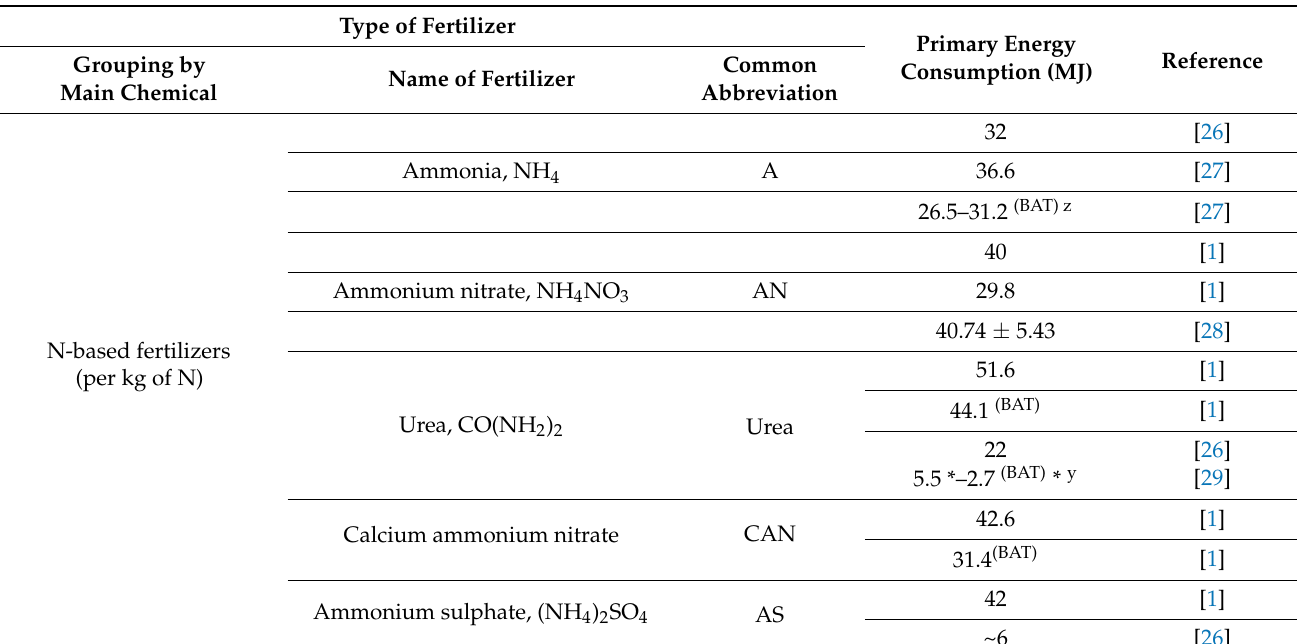
Table 1. Energy consumption, in megajoule per kilogram (MJ/kg), of the pure chemical element by the main types of mineral